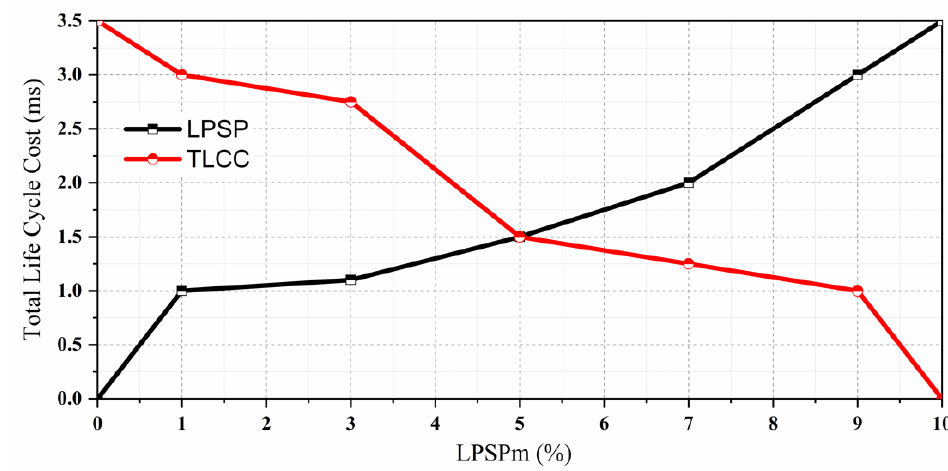
Figure 5. The TLCC and LPSP to various loss of power supply probability.